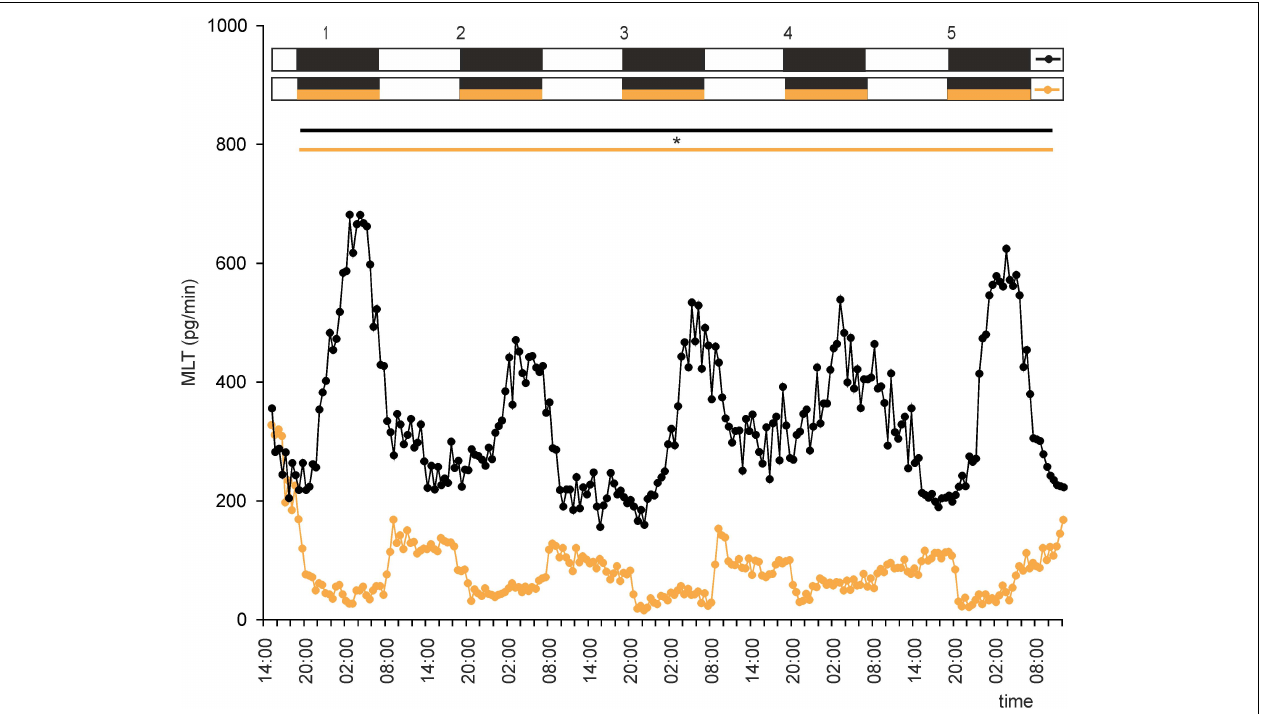
FIGURE 7 | Secretion (means, n = 4) of MLT by goose pineal organs incubated under 12 h of light and 12 h of darkness (LD) for 5 days with the presence of NE during scotophase (orange line with circles) and without it (black line with circles). White horizontal bars in upper part of image indicate photophase; black bars indicate scotophase; orange bars indicate period of NE treatment. Parallel lines with asterisk show periods, when the means differ significantly ( p < 0.05) between